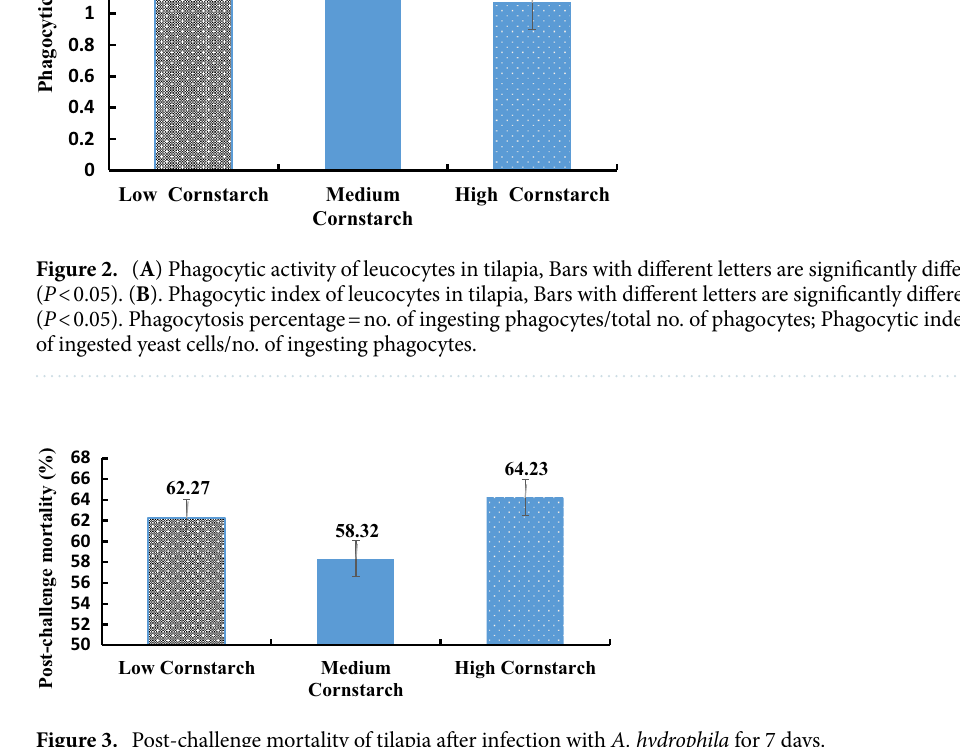
Figure 3. Post-challenge mortality of tilapia after infection with A. hydrophila for 7